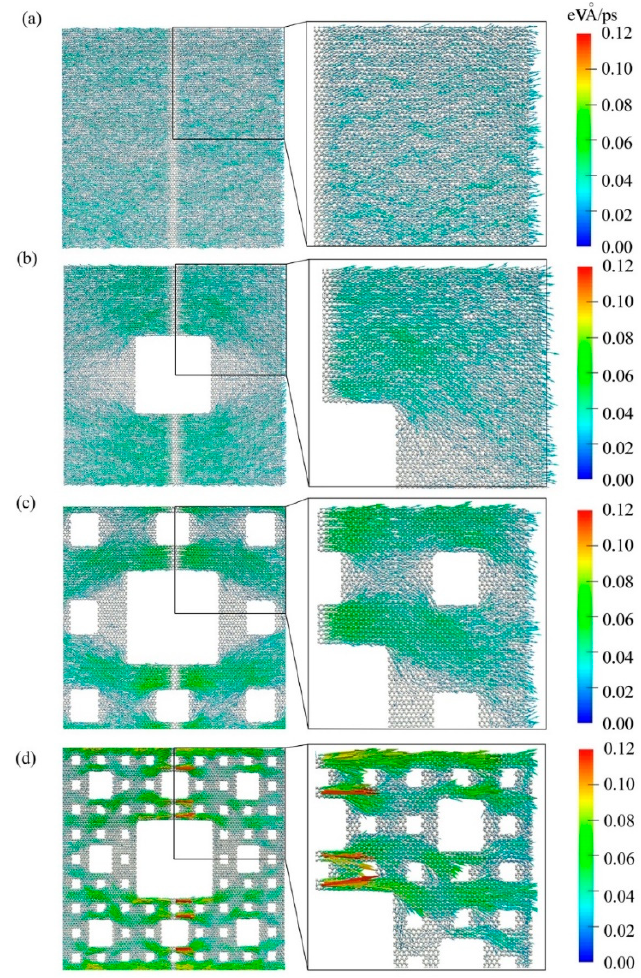
Figure 5. Spatial distribution of heat flux by vector arrows on each atom in fractal graphene in different levels under nonequilibrium steady state. ( a ), ( b ), ( c ), and ( d ) represent the fractal level numbers 0, 1, 2, and 3. The heat flux transport directions are displayed with arrows at graphene with different fractal defects. The zoom in viewport was plotted at the right side.